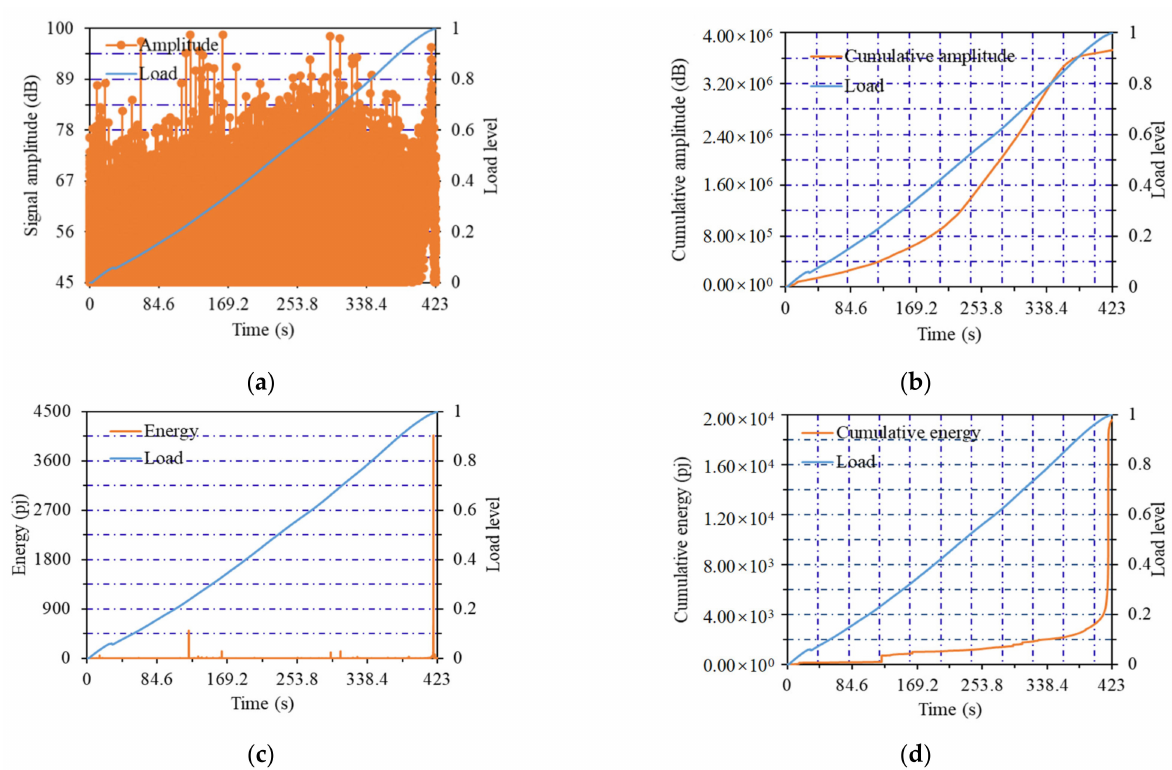
Figure 6. Curves of acoustic emission parameters of No. 6 notched beam: ( a ) Amplitude curve; ( b ) cumulative amplitude curve; ( c ) energy curve; ( d ) cumulative energy